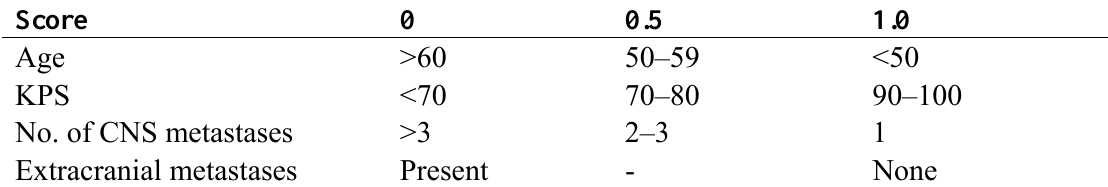
Table 2. The graded prognostic assessment